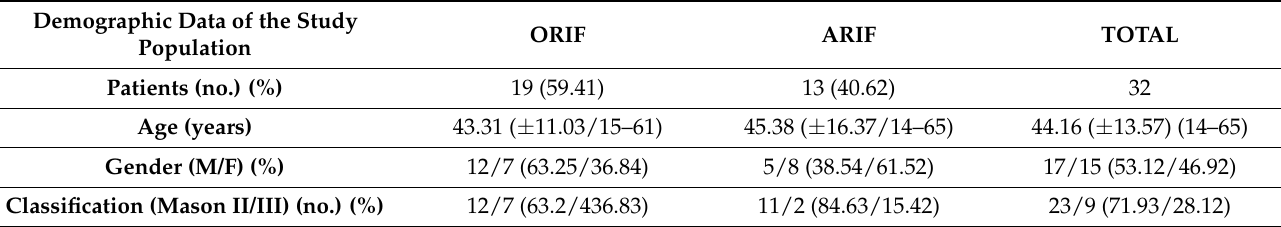
Table 1. Patients’